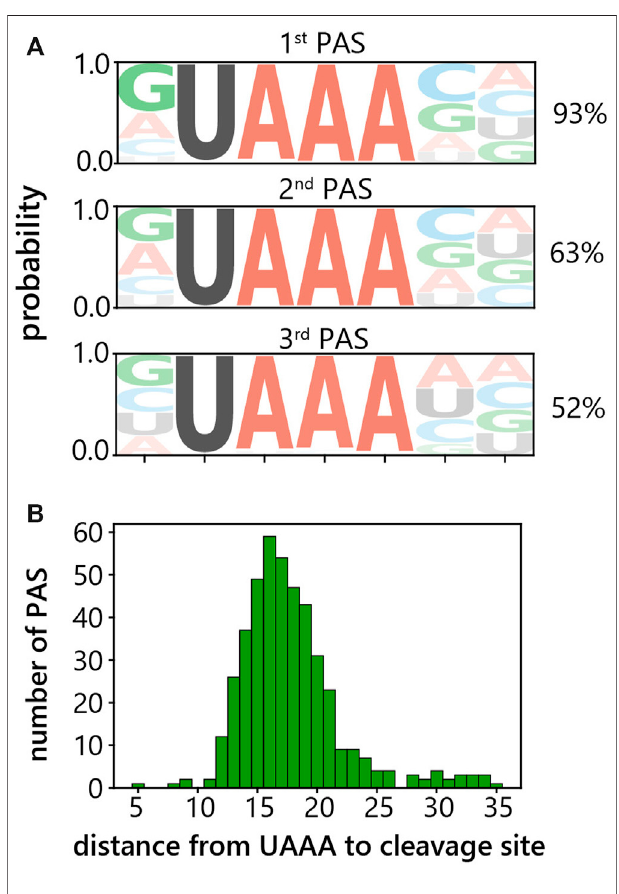
FIGURE 3 | Identi fi cation of polyadenylation signal in C. merolae. (A) Motif analysis of 500 sequences each upstream of primary, secondary and tertiary 3 ′ -end peak. Percentages indicate how many sequences out of the input contained the motif. (B) Histogram of the distance between upstream UAAA tetranucleotide and primary cleavage site.